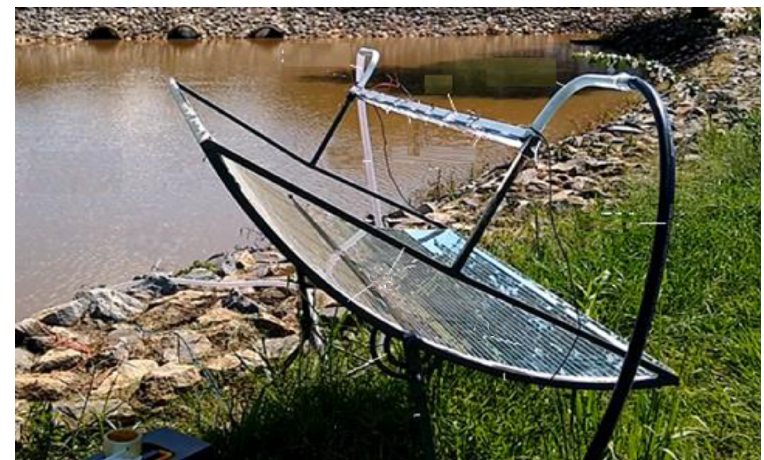
Figure 3. Concentrated Solar Power as a Parabolic Trough